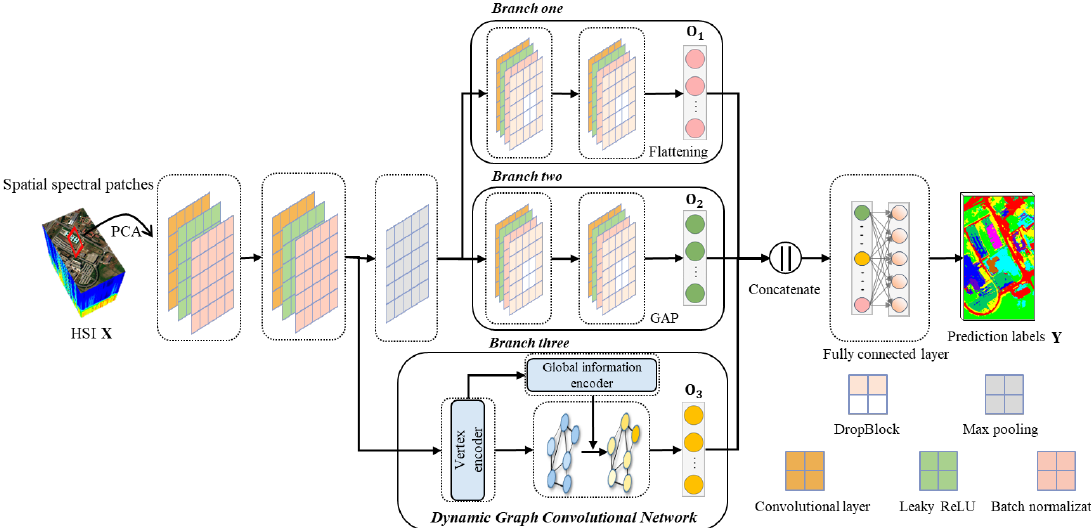
Figure 1. The architecture of the proposed DGCNet. Given an input HSI X , our method first use two convolution blocks extraction shallow features. Next, the deep spatial-spectral features are extracted based on the Flattening and Global Average Pooling (GAP) branches. The structure feature is extracted by dynamic graph convolutional module (Sec. 3.1 & 3.2). Finally, the spatial, spectral and structure features are concatenated and classified by softmax function to obtain the label Y (Sec.